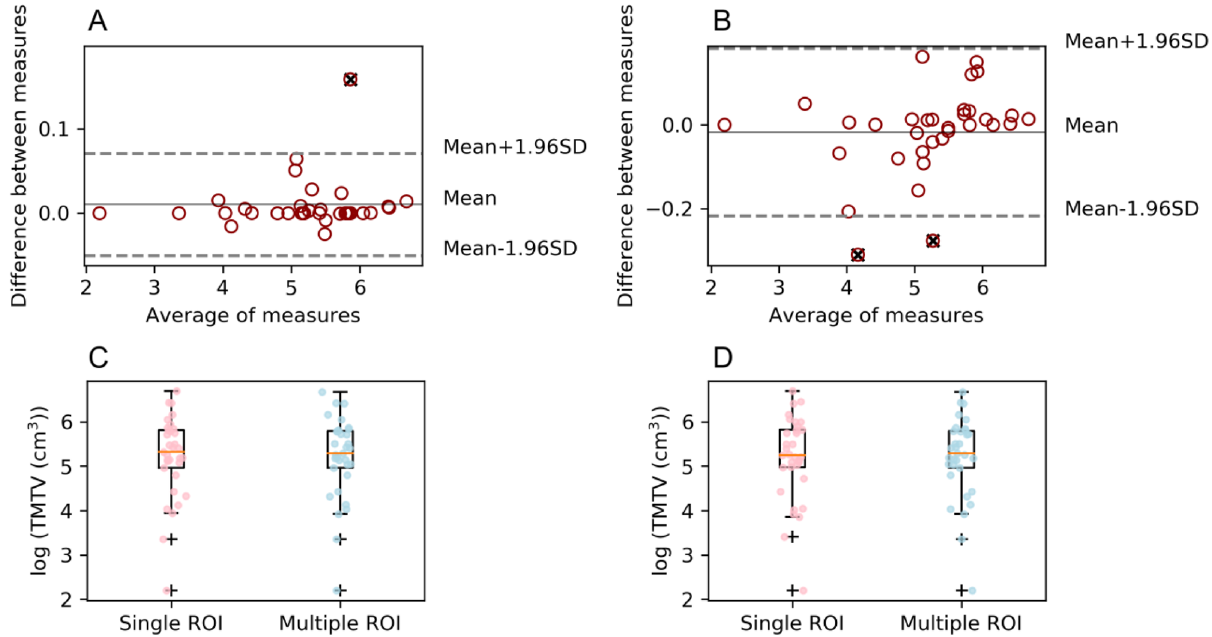
Figure 3. Multiple ROI study for the SUV > 2.5 threshold. Bland Altman analysis and Box Plot displaying the comparison of TMTV obtained using single ROI in BI and sum of multiple ROIs in BI ( A , C ) and LIFEx single ROI vs sum of multiple ROIs in BI ( B , D ).